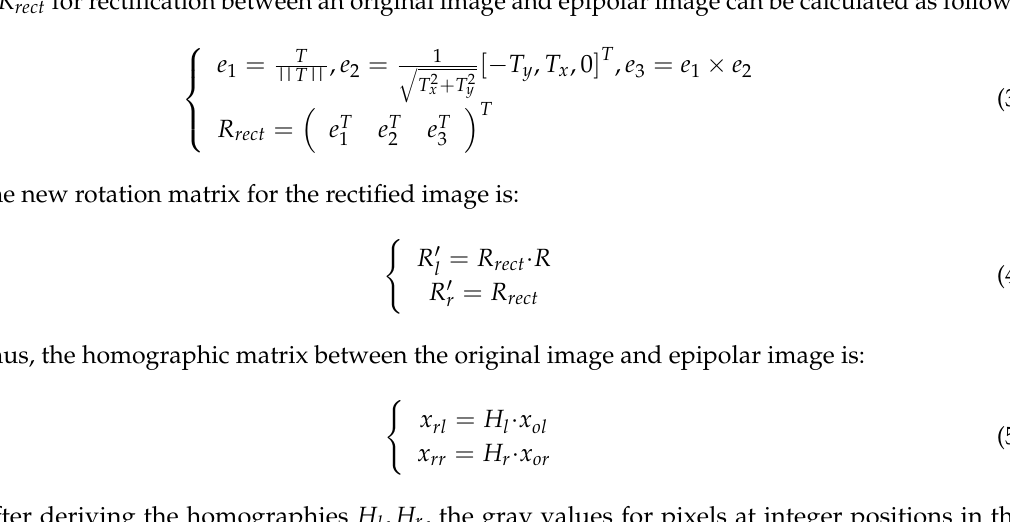
Figure 2. Two definitions of the overlap ratio: on the left, the definition in an aerial situation; and on the right the overlap ratio as defined for general purposes.